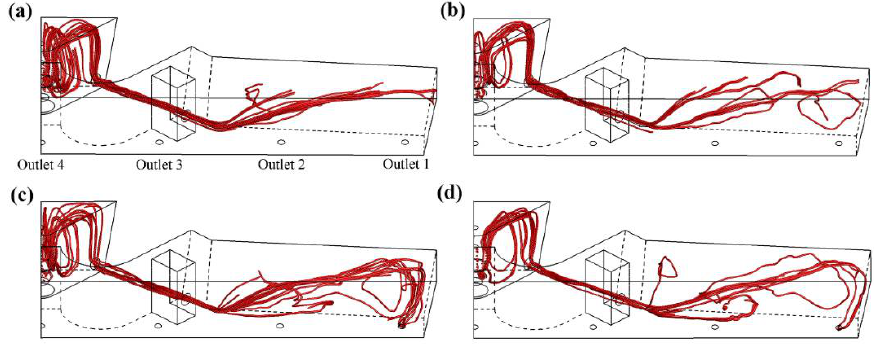
Figure 21. Path of different sizes of inclusions in case A0: ( a ) 50 μm, ( b ) 30 μm, ( c ) 10 μm, ( d ) 5 μm.